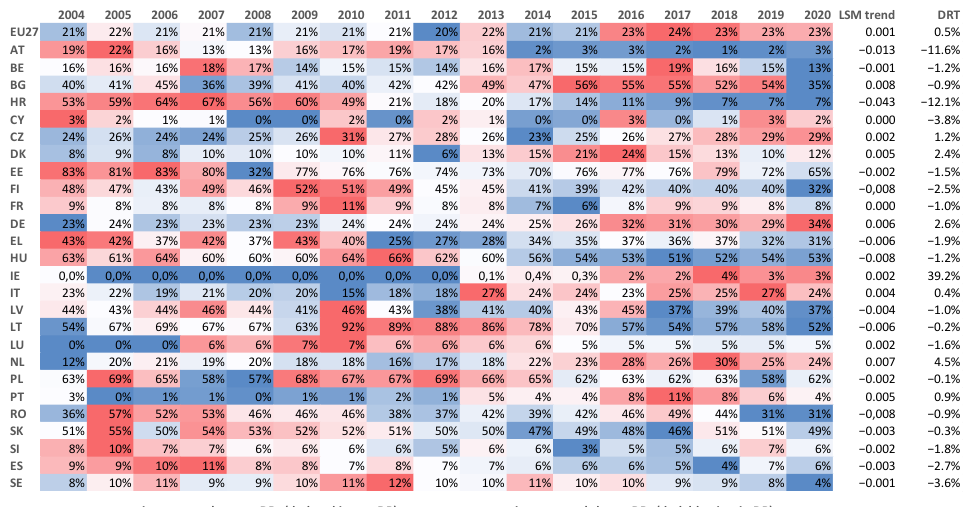
Figure 1. Values of DRs between 2004 and 2020.